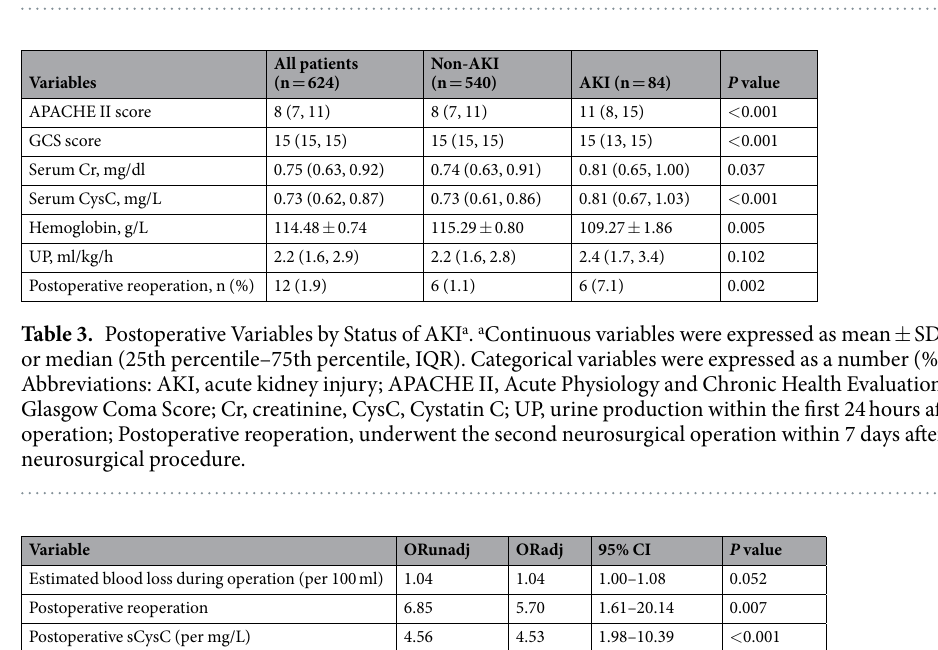
Table 2. Intraoperative Variables by Status of AKI a . a Continuous variables were expressed as mean ± SD or median (25th percentile–75th percentile, IQR). Categorical variables were expressed as a number (%). Abbreviations: AKI, acute kidney injury; MAP, mean arterial pressure; HES, hydroxyethyl starch; RBC, red blood cell.